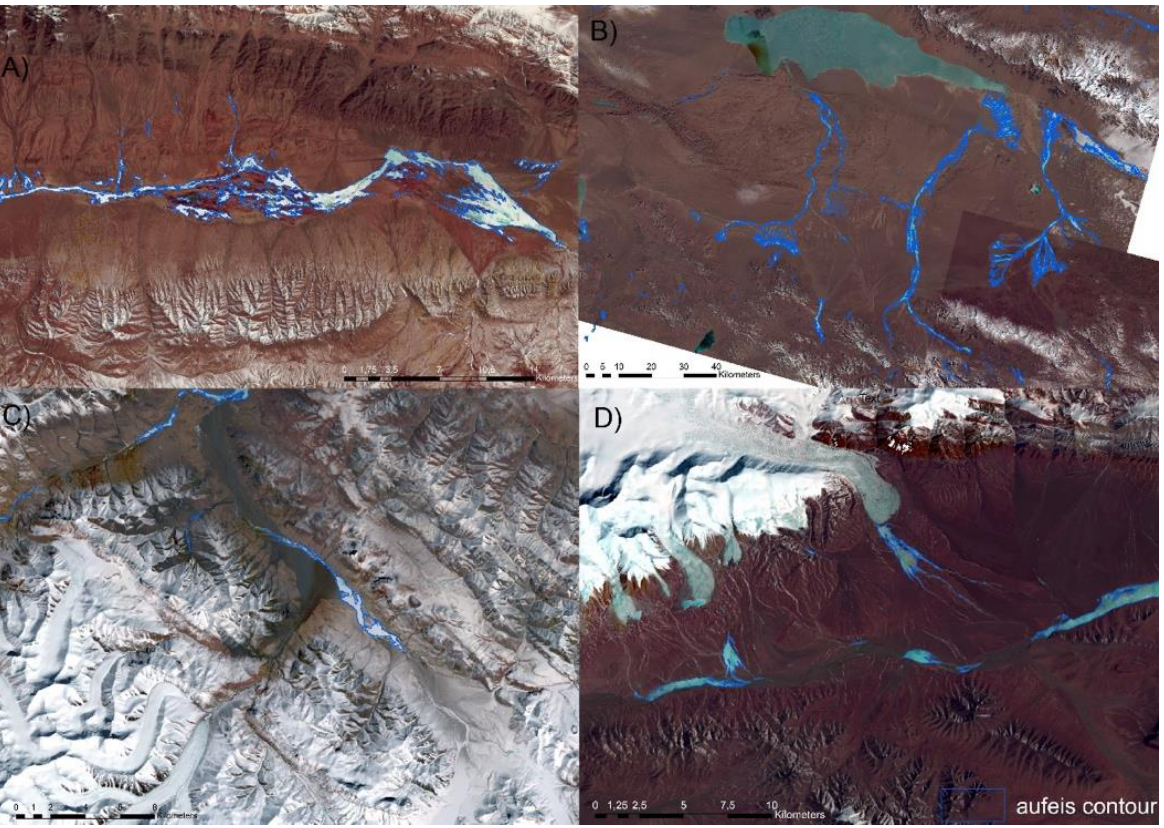
Figure 2. Fragments of Landsat 8 OLI imageries (IRGB) with Aufeis contours. Description: ( A )—typical gigantic Aufeis; ( B )—groups of sloping Aufeis; ( C , D )—Aufeis fed by melt glacier